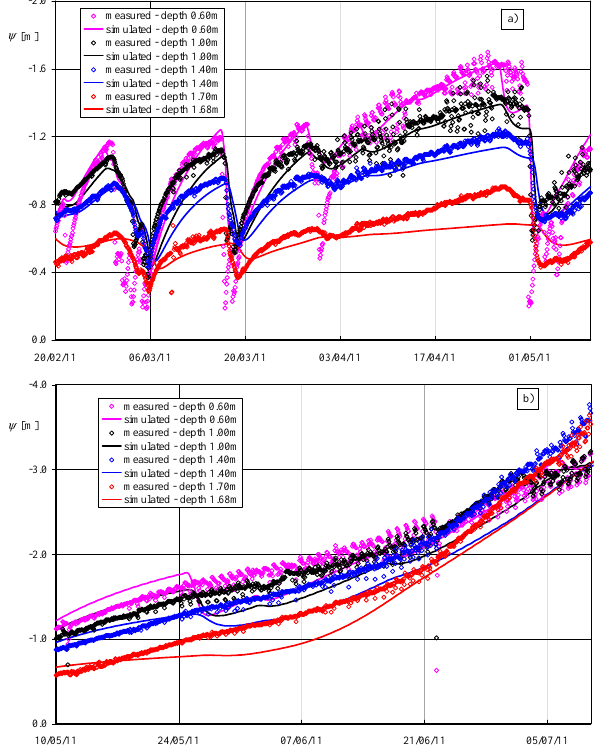
Figure 6 Fig. 6. Comparison between simulated and observed capillary pres- sure head at various depths during the period considered for model calibration: slope with leafless trees and low-developed underbrush (above); slope during the vegetation flourishing period